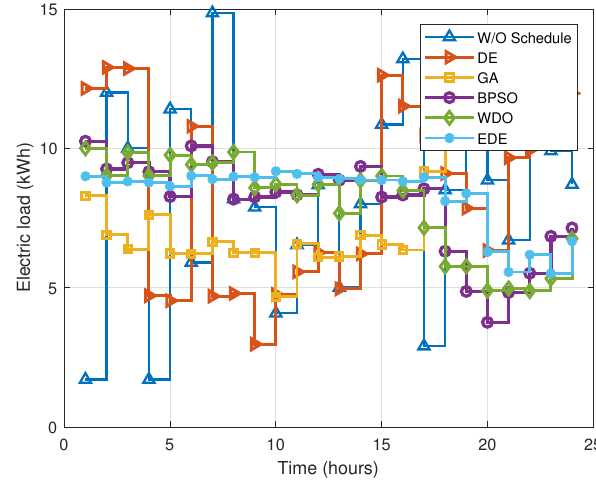
Figure 18. Hybrid appliances energy consumption